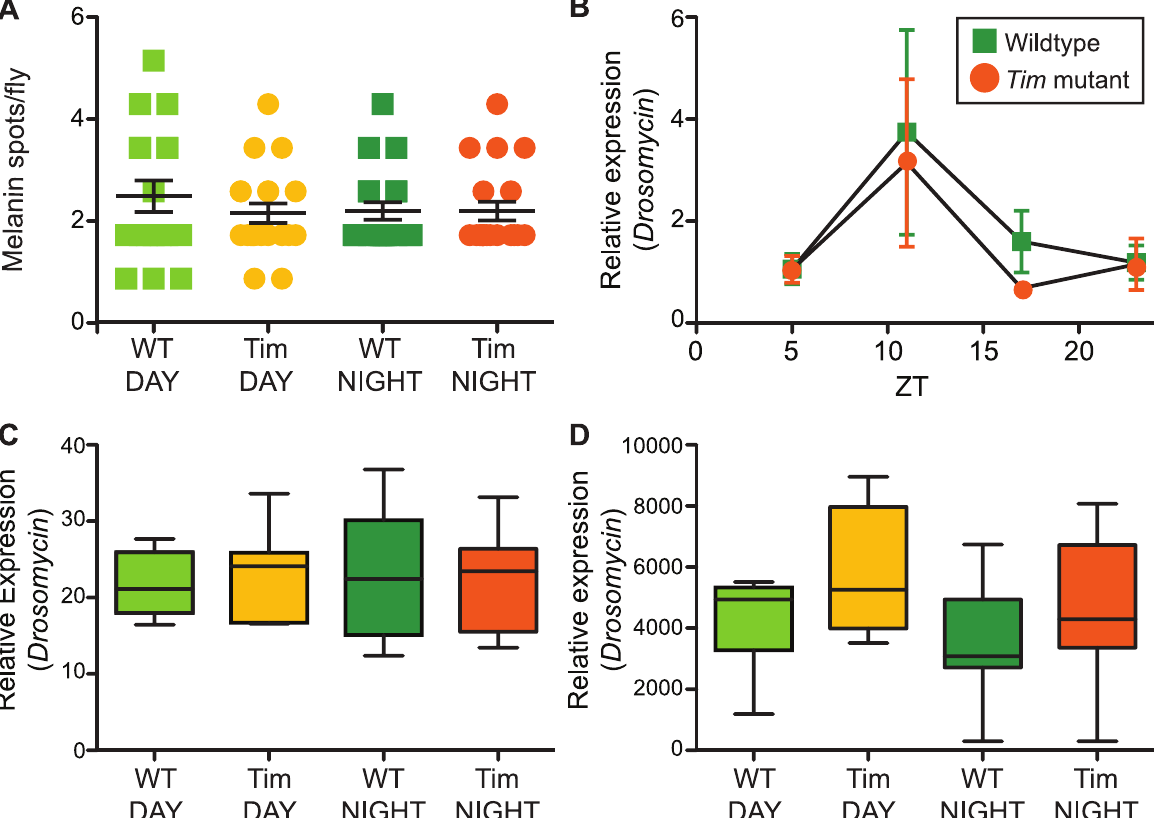
Figure 4. Tim protein does not regulate melanization or AMP gene expression. (A) Wild type and Tim mutants injected with L. monocytogenes at ZT07 (DAY) or ZT19 (NIGHT) have similar levels of melanization. p-values for pair-wise comparisons were not significant: WT (DAY) vs. Tim (DAY), p=0.3551; WT (NIGHT) vs. Tim (NIGHT), p=1.000; WT (DAY) vs. WT (NIGHT), p=0.4031; Tim (DAY) vs. Tim (NIGHT), p=0.8717. p-values were obtained by unpaired, two-tailed t-test; n=18–20 flies per genotype per condition. (B) Basal (uninduced) levels of Drosomycin expression were increased at ZT11 relative to ZT05, ZT17, ZT23 in both wild type and Tim mutants, suggesting that this change in expression is not mediated by Tim . (C) Infection-induced levels of Drosomycin expression were not significantly different after injection of wild type and Tim mutants with M. luteus at ZT05 (DAY) or ZT 17 (NIGHT). Every pair-wise comparison resulted in p-values greater than 0.05 (not significant) by Mann-Whitney test. (D) Infection- induced levels of Diptericin expression were not significantly different after injection of wild type and Tim mutants with E. coli at ZT05 (DAY) or ZT17 (NIGHT). Every pair-wise comparison resulted in p-values greater than 0.05 (not significant) by Mann-Whitney test.